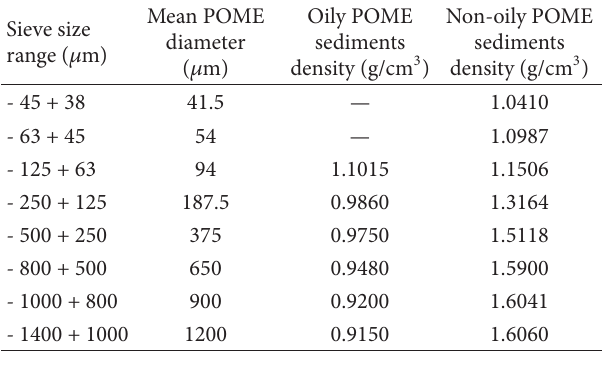
F 7: �ifferent shapes and lengths of oily POME �bres amid POME particles.